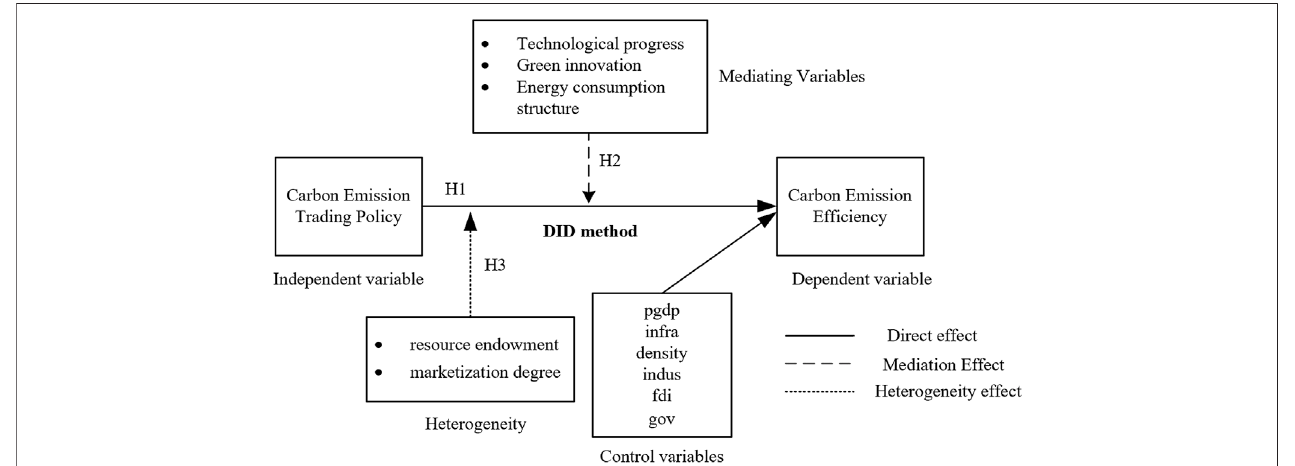
FIGURE 1 | The practical and theoretical